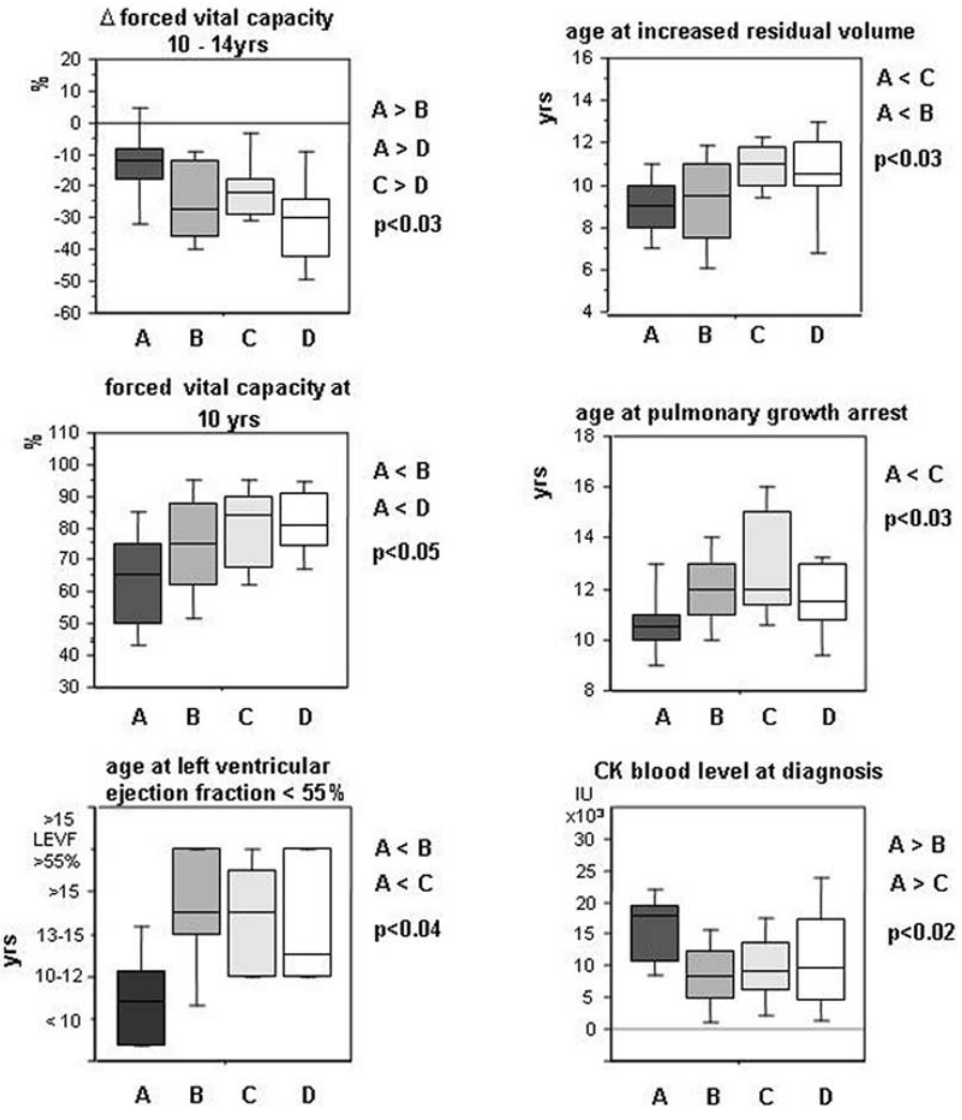
Figure 4. Pulmonary and cardiac function variables not used to constitute the model. Group A patients had poorest respiratory and myocardial functions and highest serum CK levels at diagnosis. These variables, not used in the multivariate model, also corroborate its predictive relevance (indicated p values are obtained by Kruskal-Wallis test; clusters were compared by a multiple range post-test with p , 0.05).